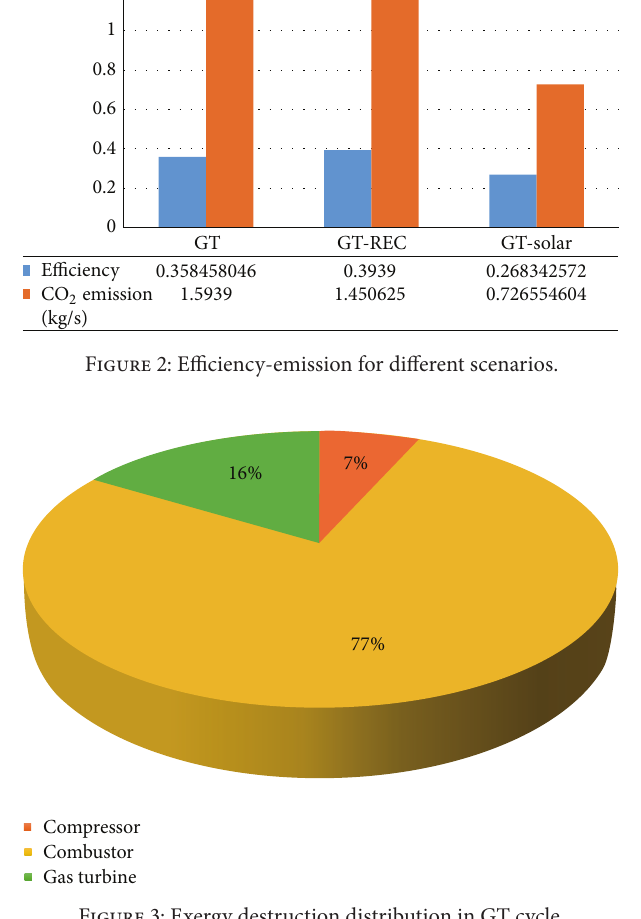
Figure 3: Exergy destruction distribution in GT cycle.